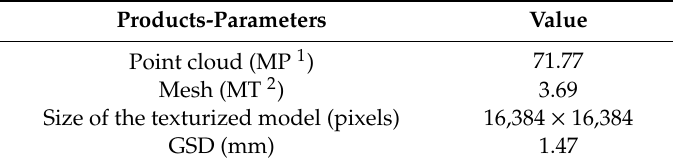
Table 1. Summary of the partial products derived from the photogrammetric process.